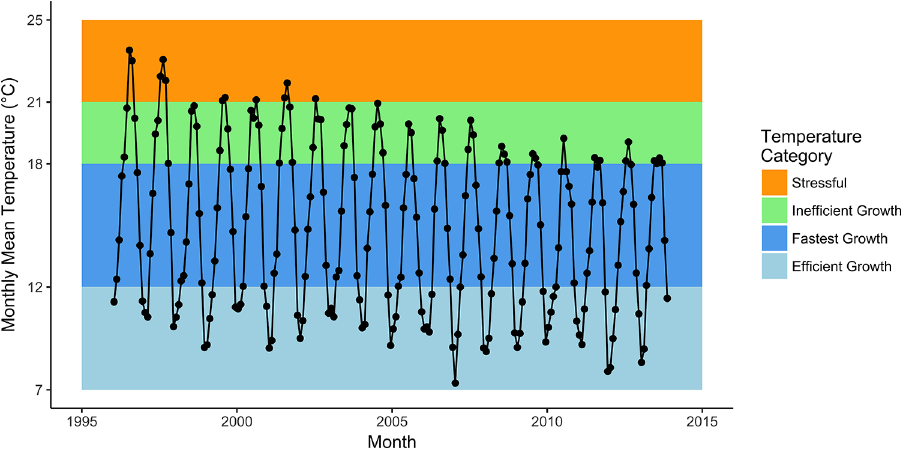
Fig 8. Monthly mean temperature of Carmel River during 1996–2013. Also shown are temperature categories for steelheadrearing habitat, adaptedfrom [40] and the bioenergetics model; see text for further